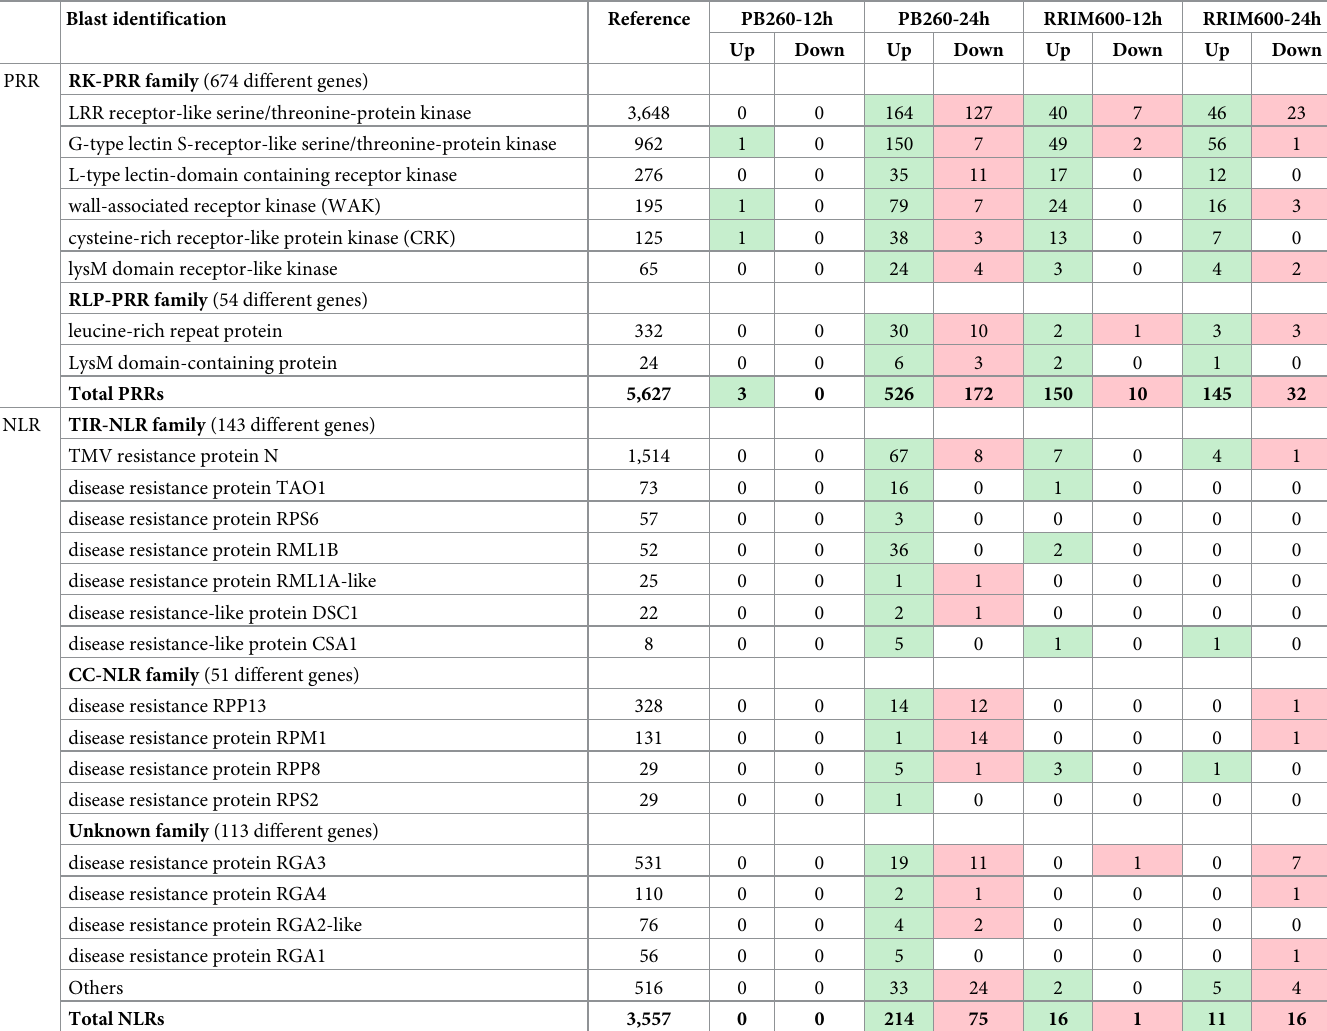
Table 3. List of putative PRR- and NLR-encoding genes differentially expressed after cassiicolin treatment on PB260 and RRIM600